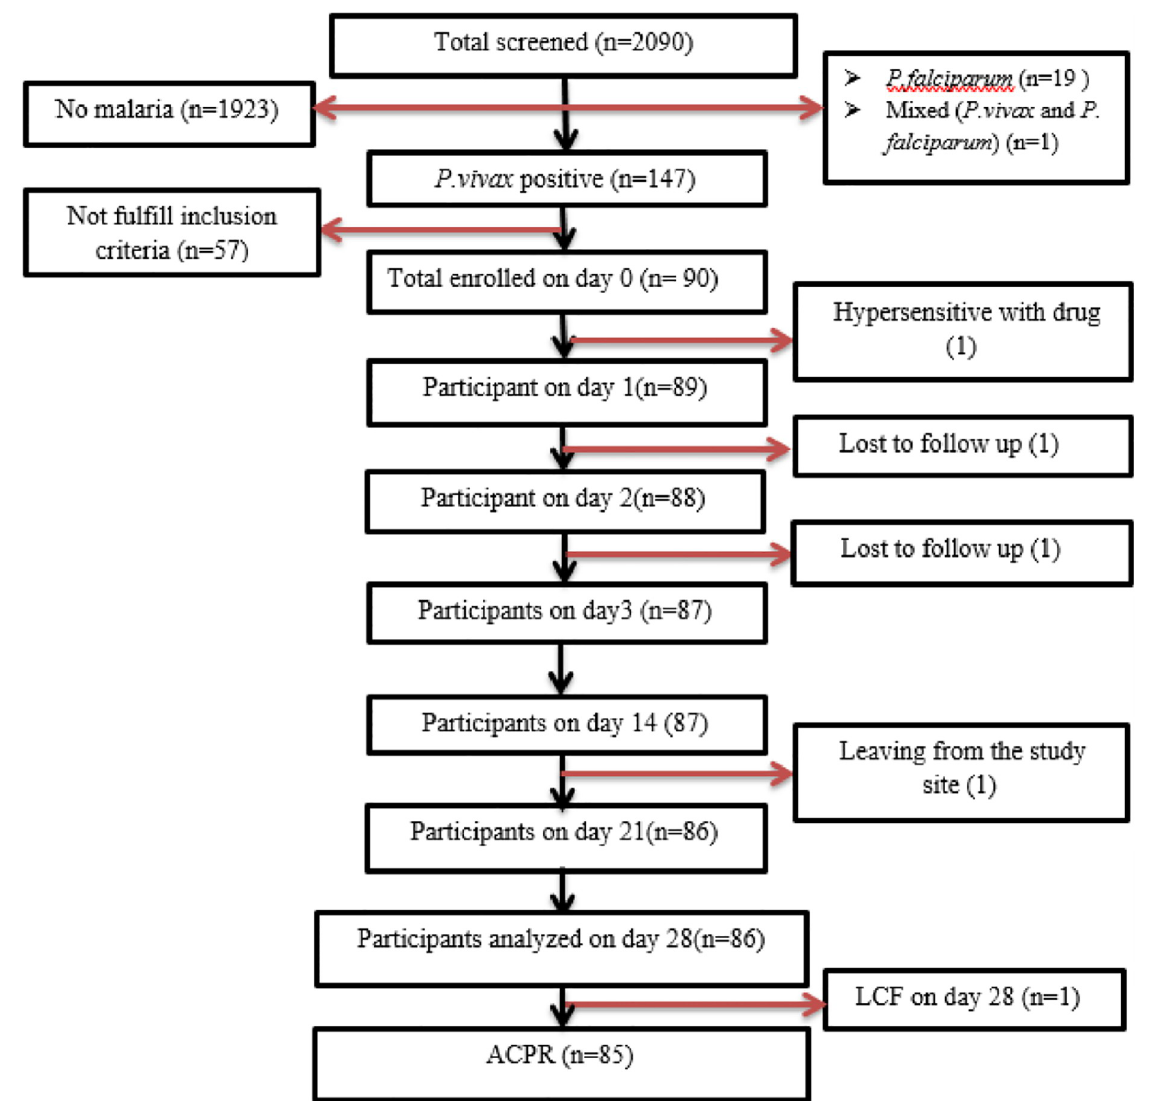
Fig 1. Flow chart of study participants’ recruitment and follow-up at Shewa Robit Health Centre, Northeast Ethiopia from November 2020 to March 2021.